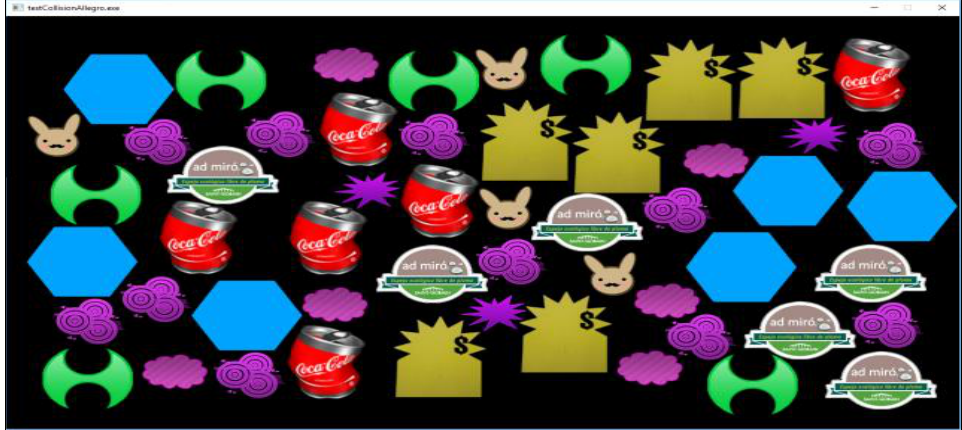
Figure 1. Mockup design for the digital printing of pieces with diverse sizes.